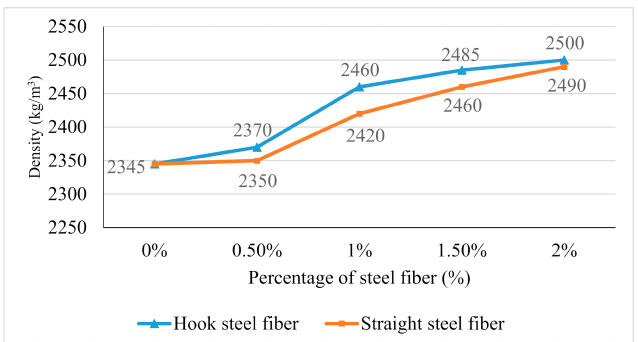
Figure 4. Density of hook and straight steel fiber against steel fibers addition.